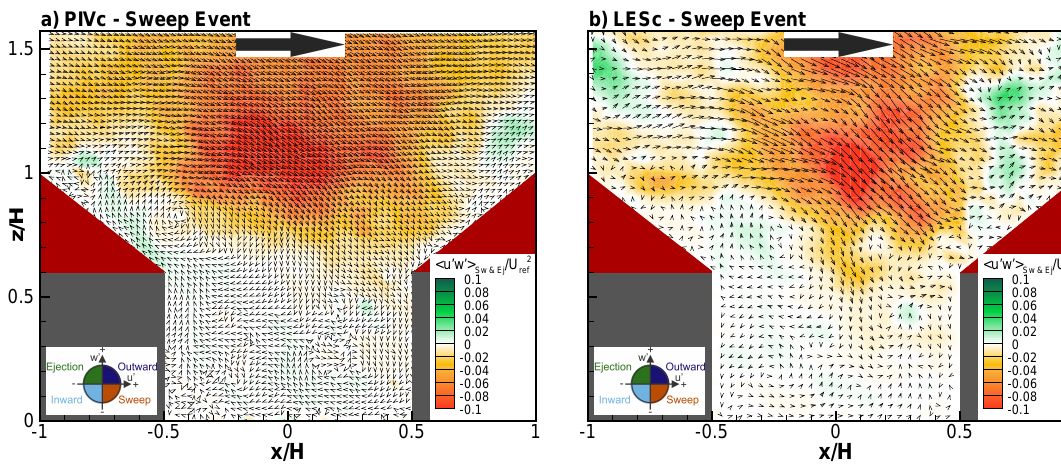
Figure 7. The characteristic examples of the sweep event (orange) at y / H = 0 for ( a ) PIVc and ( b )